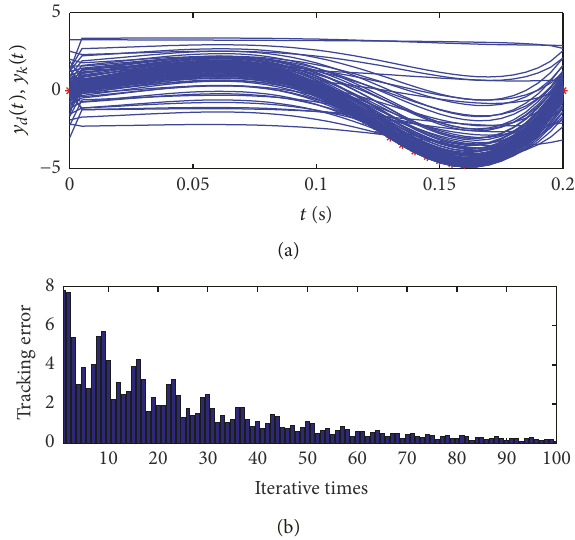
Figure 1: The system output 𝑦 𝑘 (𝑡) (blue line), the desired trajectory 𝑦 (𝑡) (red line), and the tracking error for (83). 𝑑